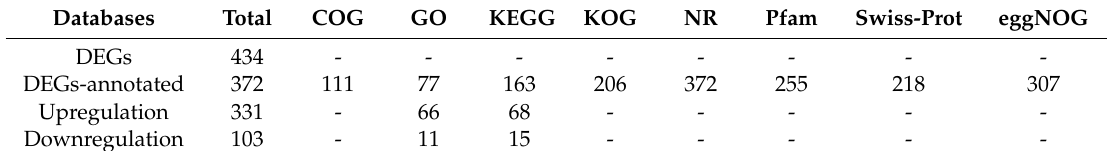
Table 1. Statistics of the differentially expressed gene (DEG) results.